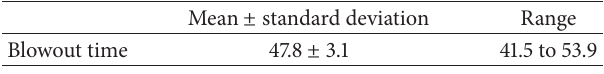
Table 2: Results of blowout time using laser speckle flowgraphy.